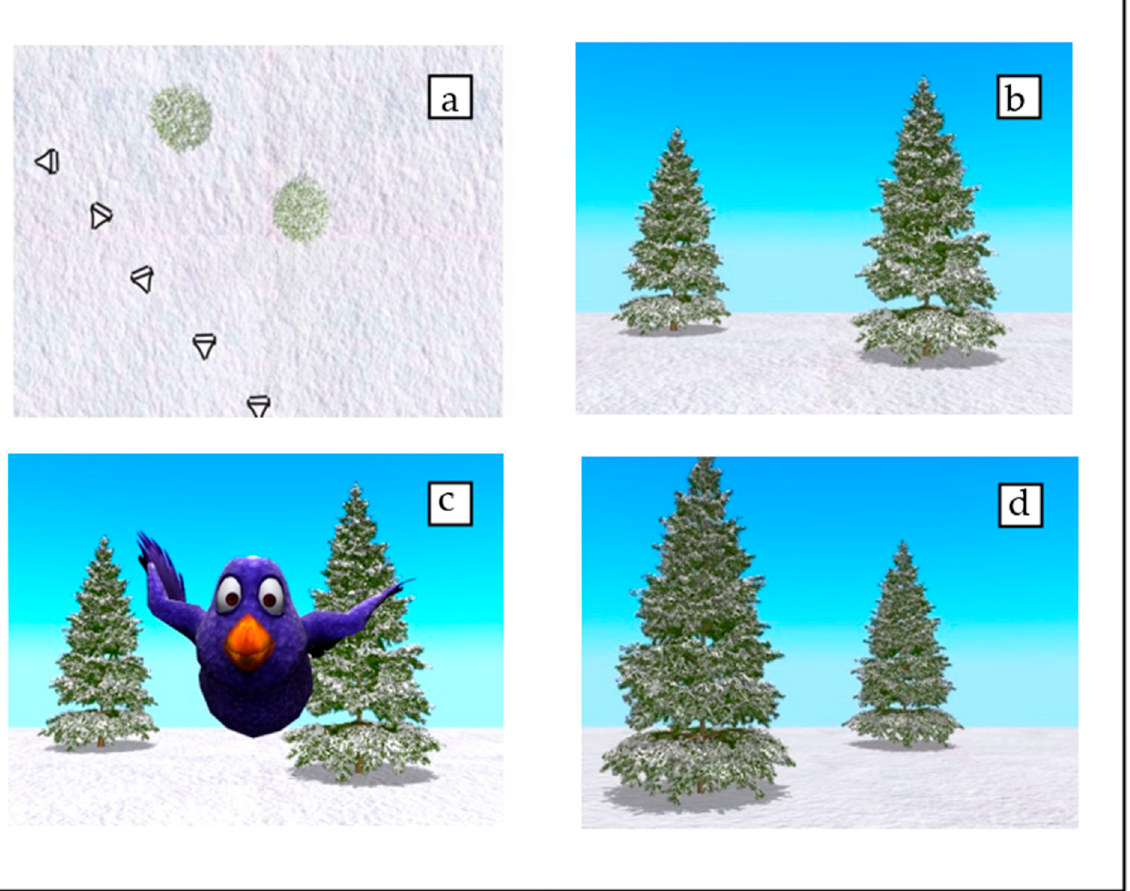
Figure 1. Camera path for an example trial. Panel ( a ) shows the top view of the camera path, indicating camera angle and position at five points. Panels ( b , d ) show the initial and final position of the camera, resulting in a 90° turn to the left of the center of the visual scene. After the initial image ( b ), Pico the bird appears ( c ) and hides in one of the two trees. Next, the camera shifts, resulting in the final image ( d ). Finally, children are asked to indicate in which tree Pico is hidden by pressing the correct tree on the touchscreen. (Image and caption adapted from [32]).